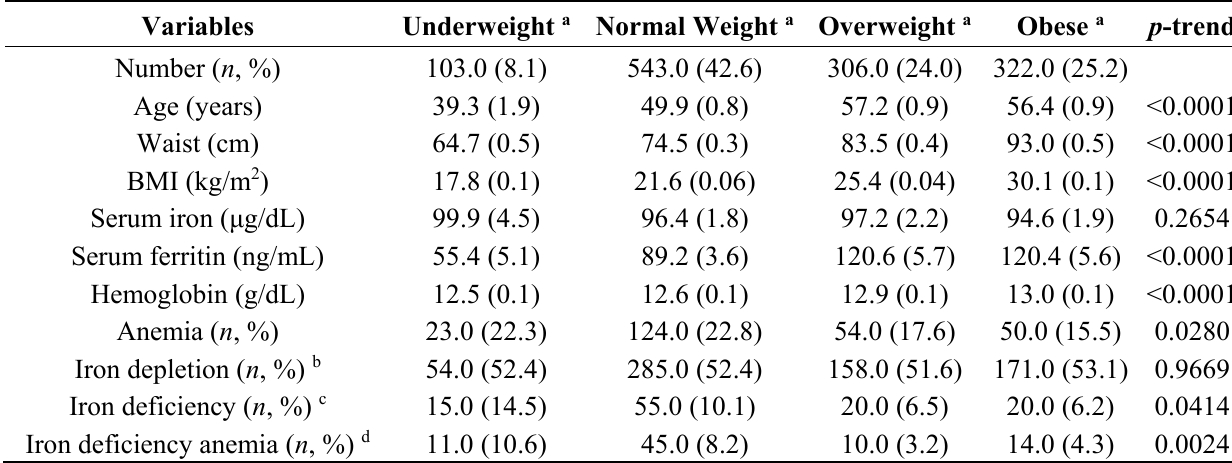
Table 1. Relationship between iron status and body mass index in female aged ≥19 years ( n =